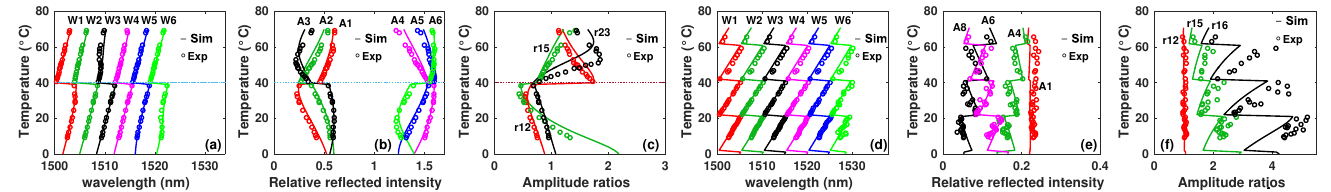
Figure 2. Graphical comparison between a few simulated and measured: ( a , d ) wavelength peak positions, ( b , e ) peaks amplitudes, ( c , f ) amplitude ratios of filters 1 and 2, respectively; in ( b ) A4–A6 are shifted right 1 unit for clarity